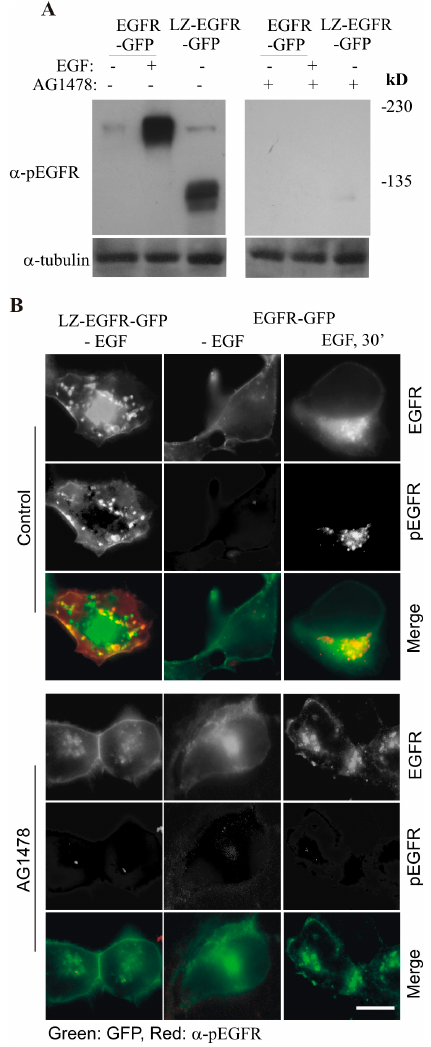
Figure 4. Phosphorylation of LZ-EGFR-GFP and the dependence on intrinsic tyrosine kinase activity. ( A ) Immunoblotting. 293T cells were transiently transfected with EGFR-GFP or LZ-EGFR-GFP. The cells were serum starved for 24 h and then were treated with EGF and/or AG1478 as indicated. Cell lysates were subjected to immunoblotting analysis with mouse anti-pEGFR antibody; ( B ) Immunofluorescence. 293T cells transiently transfected with either LZ-EGFR-GFP or EGFR-GFP were serum starved for 24 h. The cells were then treated with EGF and/or AG1478 as indicated. EGFR phosphorylation was examined by anti-pEGFR antibody followed by the secondary antibody conjugated with TRITC. Co-localization (yellow) of LZ-EGFR-GFP or EGFR-GFP (green) with p-EGFR (red) was determined by indirect immunofluorescence. Size bar = 20 µm.